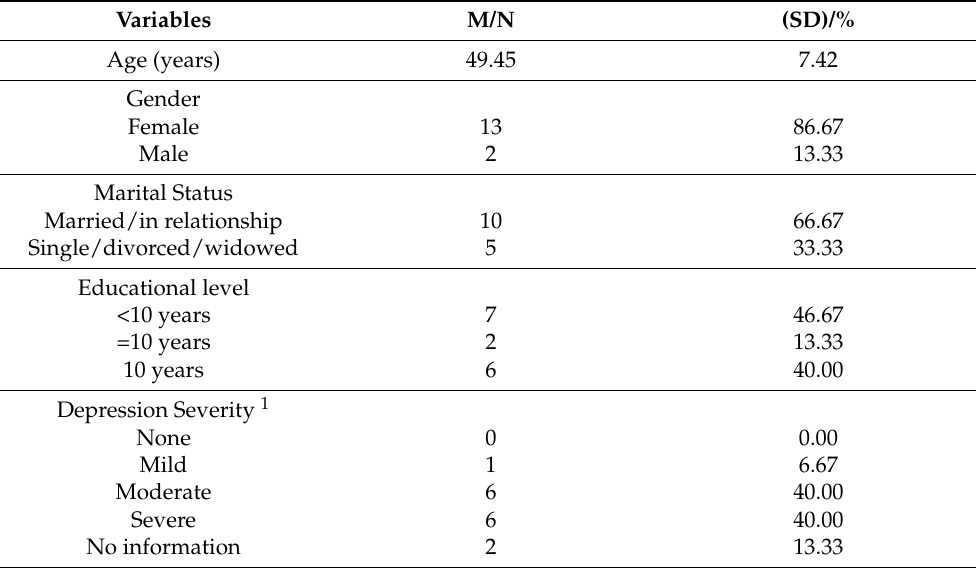
Table 1. Descriptive statistics and sociodemographic characteristics of the sample ( n =